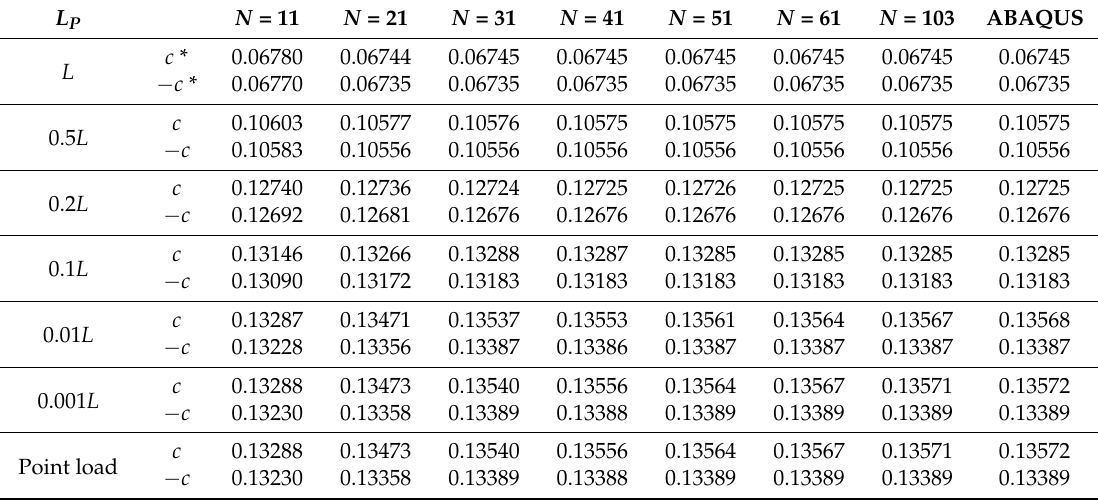
Table 1. Convergence study of the HDQ (harmonic differential quadrature) center deflection w ( ± c ,0 ) / w n for the C-C sandwich panels under locally distributed load ( M = 9). L P N = 11 N =